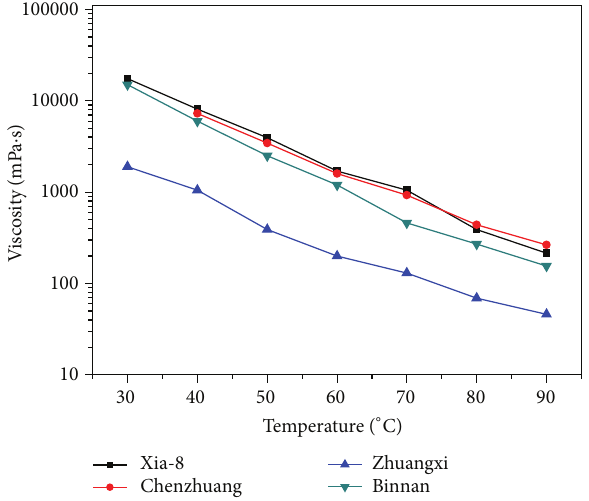
Figure 1: Viscosity-temperature curves of four types of heavy